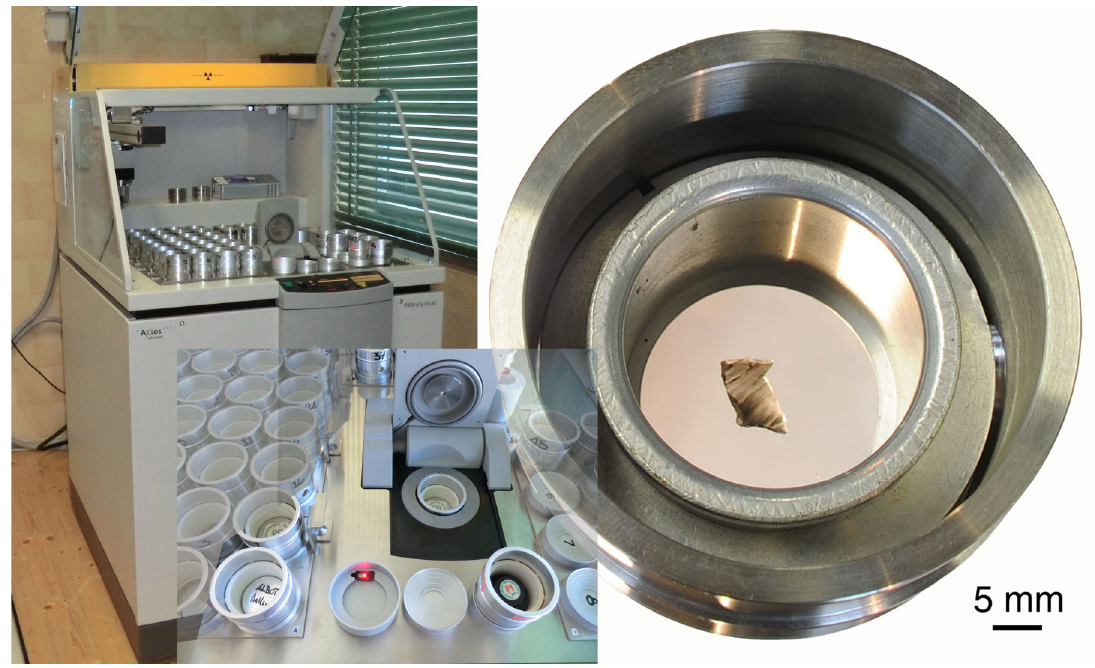
Figure 4: WD-XRF spectrometer used for chemical characterization of the obsidian samples. The spectrometer can accommo- date up to 48 specimen holders; on the right the detail of one sample holder closed at the base by a thin sheet of Mylar© in the center of which is placed a very small obsidian artefact which seems suspended in the